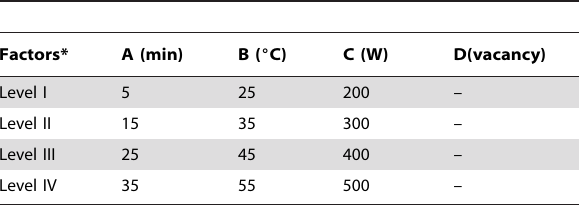
Table 1. Assignment of the levels and factors in the experimental design using an orthogonal matrix L 16 (4 5 ).